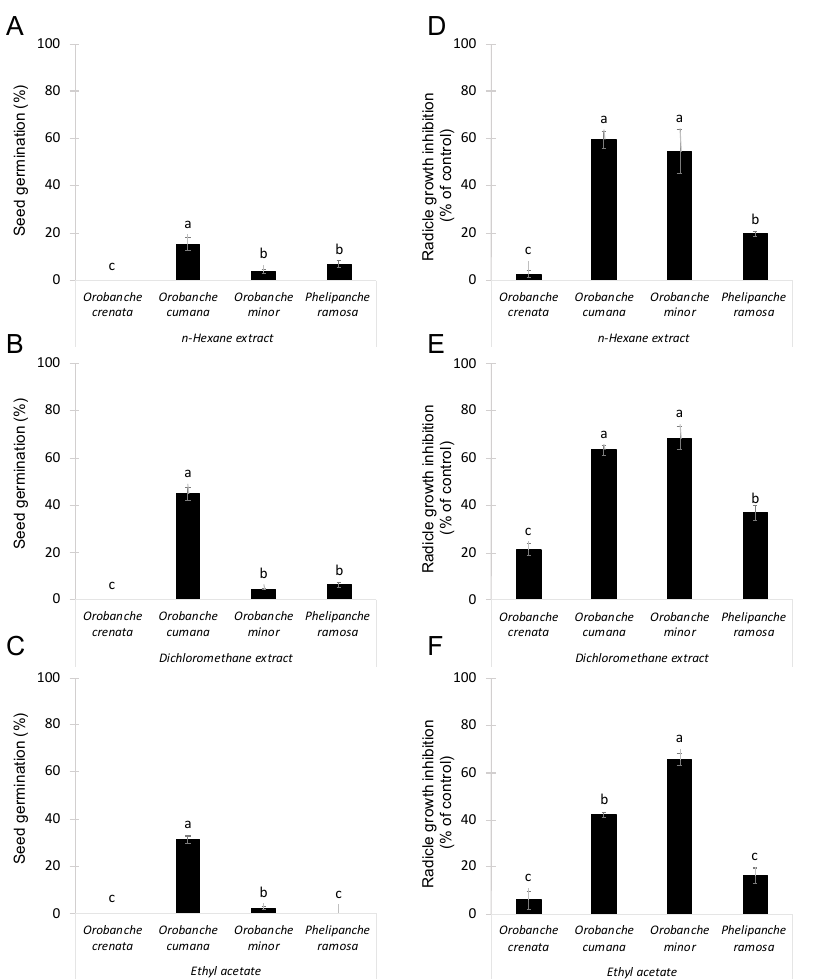
Figure 1. Allelopathic effects on suicidal germination ( A – C ) and radicle growth ( D – F ) of 4 broomrape species: Orobanche crenata, Orobanche cumana, Orobanche minor and Phelipanche ramosa induced by extracts prepared from sequential extractions with n -hexane ( A , D ), dichloromethane ( B , E ), and ethyl acetate ( C , F ) of Conyza bonariensis shoots In each figure, bars with different letters are significantly different according to the Tukey test ( p < 0.05). Error bars represent the standard error of the mean.